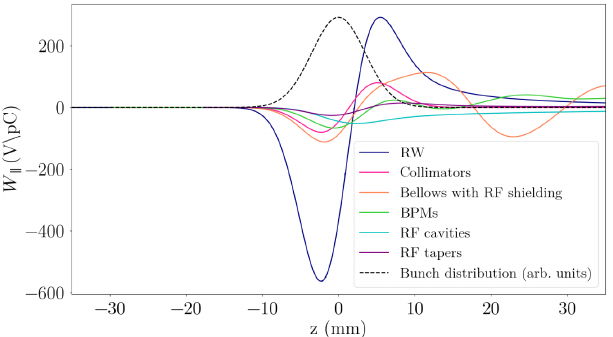
FIG. 19. Longitudinal wake potentials for a Gaussian bunch with nominal bunch length σ z ¼ 3 . 5 mm due to the main FCC-ee components compared with the RW contribution (blue